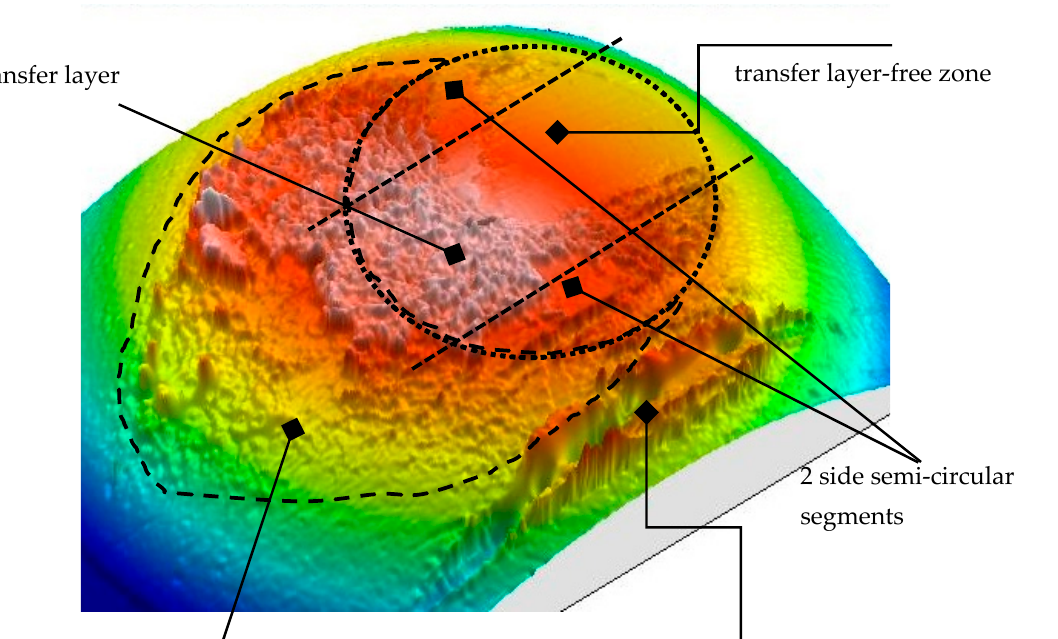
Figure 11. Confocal image and the classification of the wear scar features on the steel ball after friction against non-hydrogenated W-C coating up to 2000 m zone (reprinted with permission from Ref. [25], 2021, Elsevier).